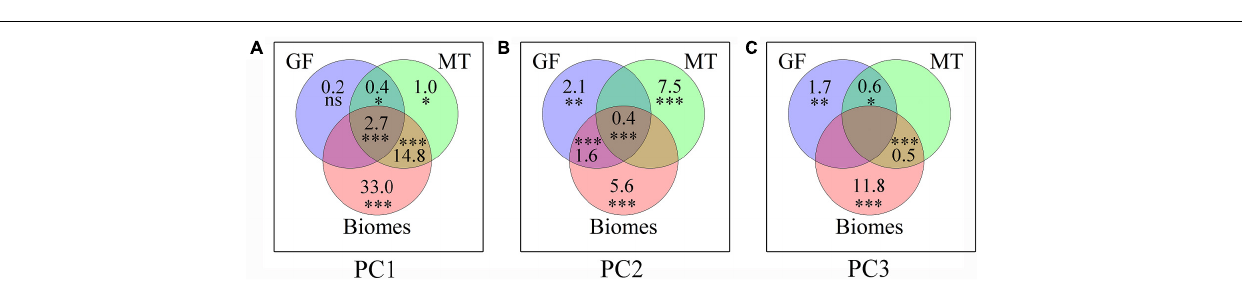
FIGURE 4 | Relative contributions (%) of plant growth form, mycorrhizal type, and biome to the first three main principal components (i.e., PC1–PC3) of root trait covariation. The intersections represent variation that is jointly explained by two or more variable categories. (A) PC1; (B) PC2; (C) PC3. The number (lower-right) indicates the variations that are unexplained proportion by these three groups. The significances of each category are tested using 999 permutations. ∗∗∗ P < 0.001; ∗∗ P < 0.01; ∗ P < 0.05; ns P > 0.05. GF, plant growth form; MT, mycorrhizal